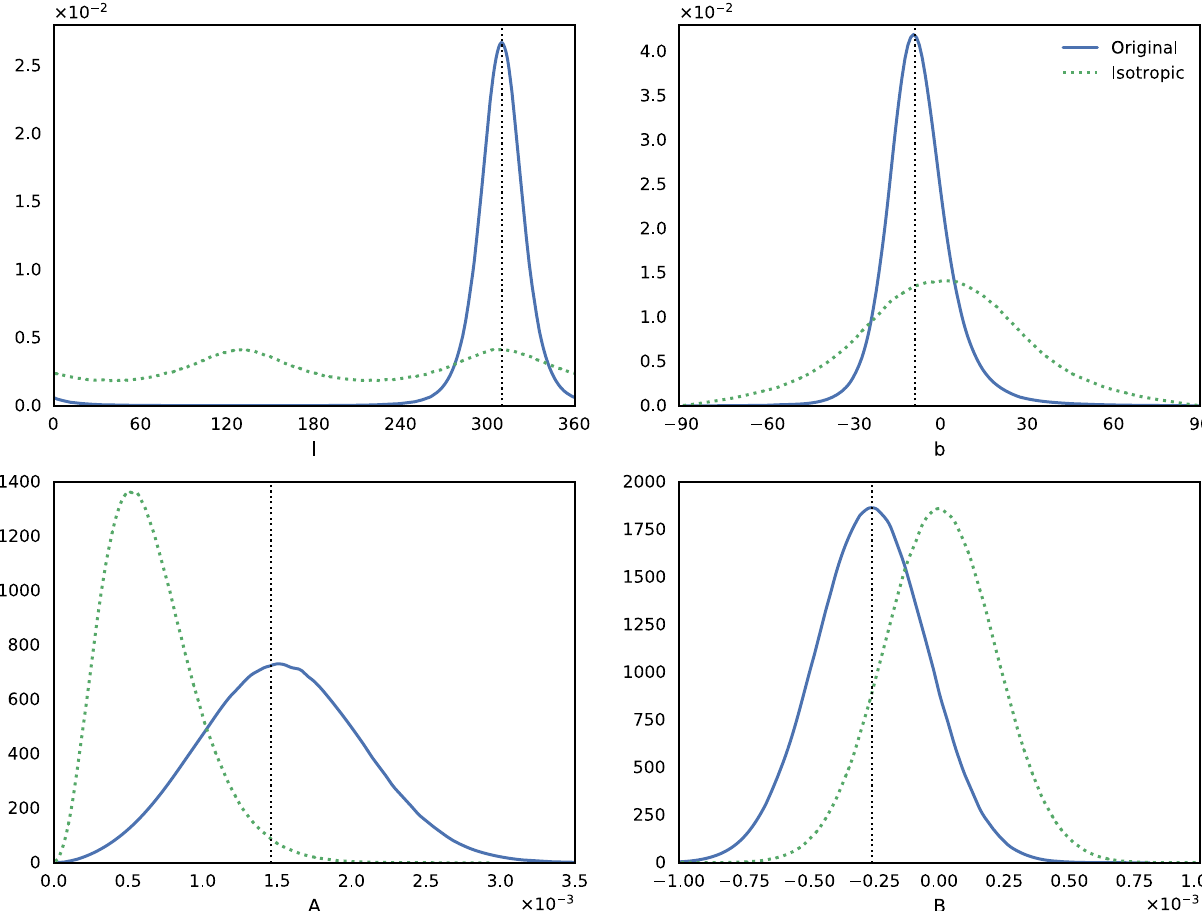
Fig. 4 Best-fitting dipole direction (star) of the JLA data set. Scatter points represent dipole directions and magnitudes generated by MCMC sampling of original samples